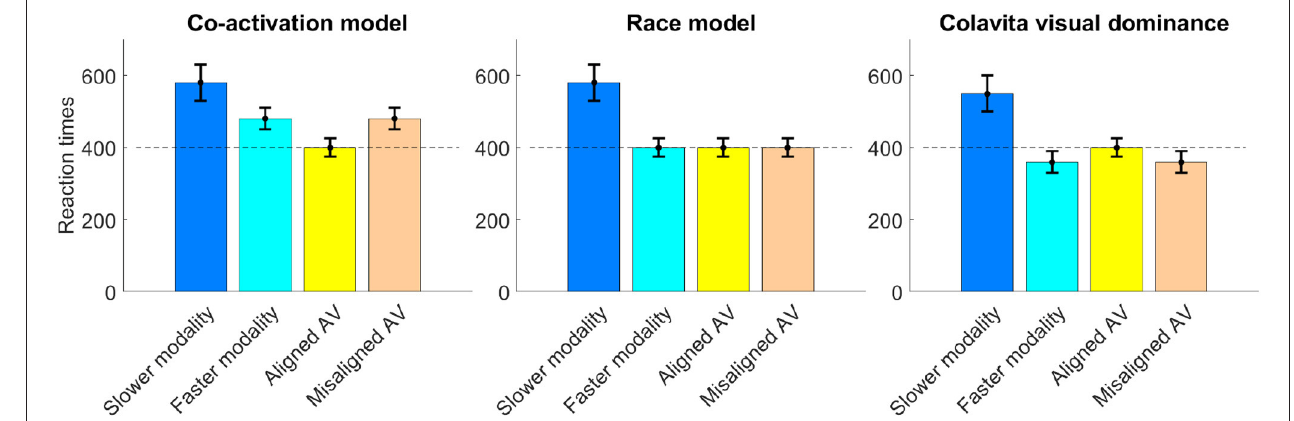
FIGURE 2 | The time course of each of the discussed RT models is depicted showing the relation between unimodal and bimodal RTs, where typically in speech recognition the faster RT is measured in the A condition and the slower RT in the V